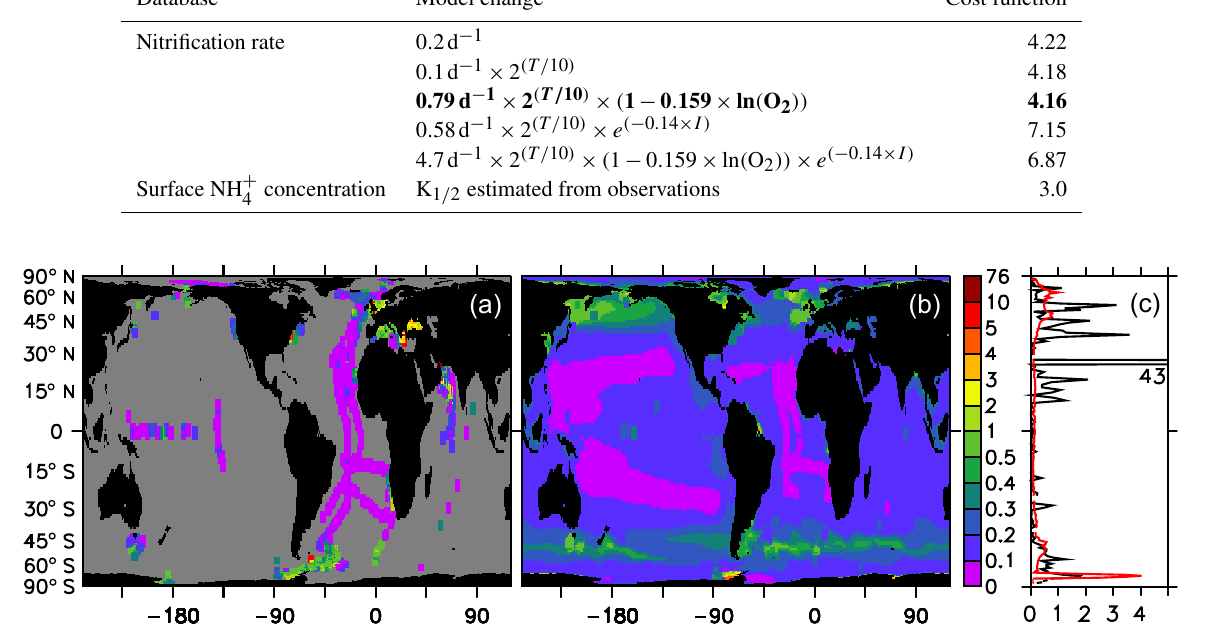
Figure 6. Surface NH + concentration (µmolL − 1 ). (a) Observations (symbol size is 5 ◦ × 5 ◦ ). (b) Model results are for the same months 4 where there are observations, and annual averages everywhere else. (c) Zonal average. Black: observations; red: model results. Model results are for the same months and longitudes as the observations. Latitude y axis to the left of panel (a)